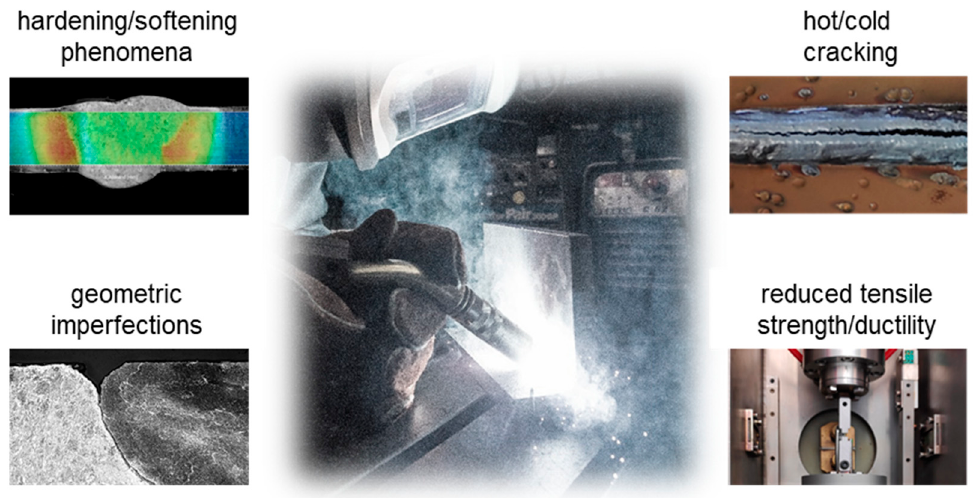
Figure 1. Overview of Defects and irregularities in the welding area.